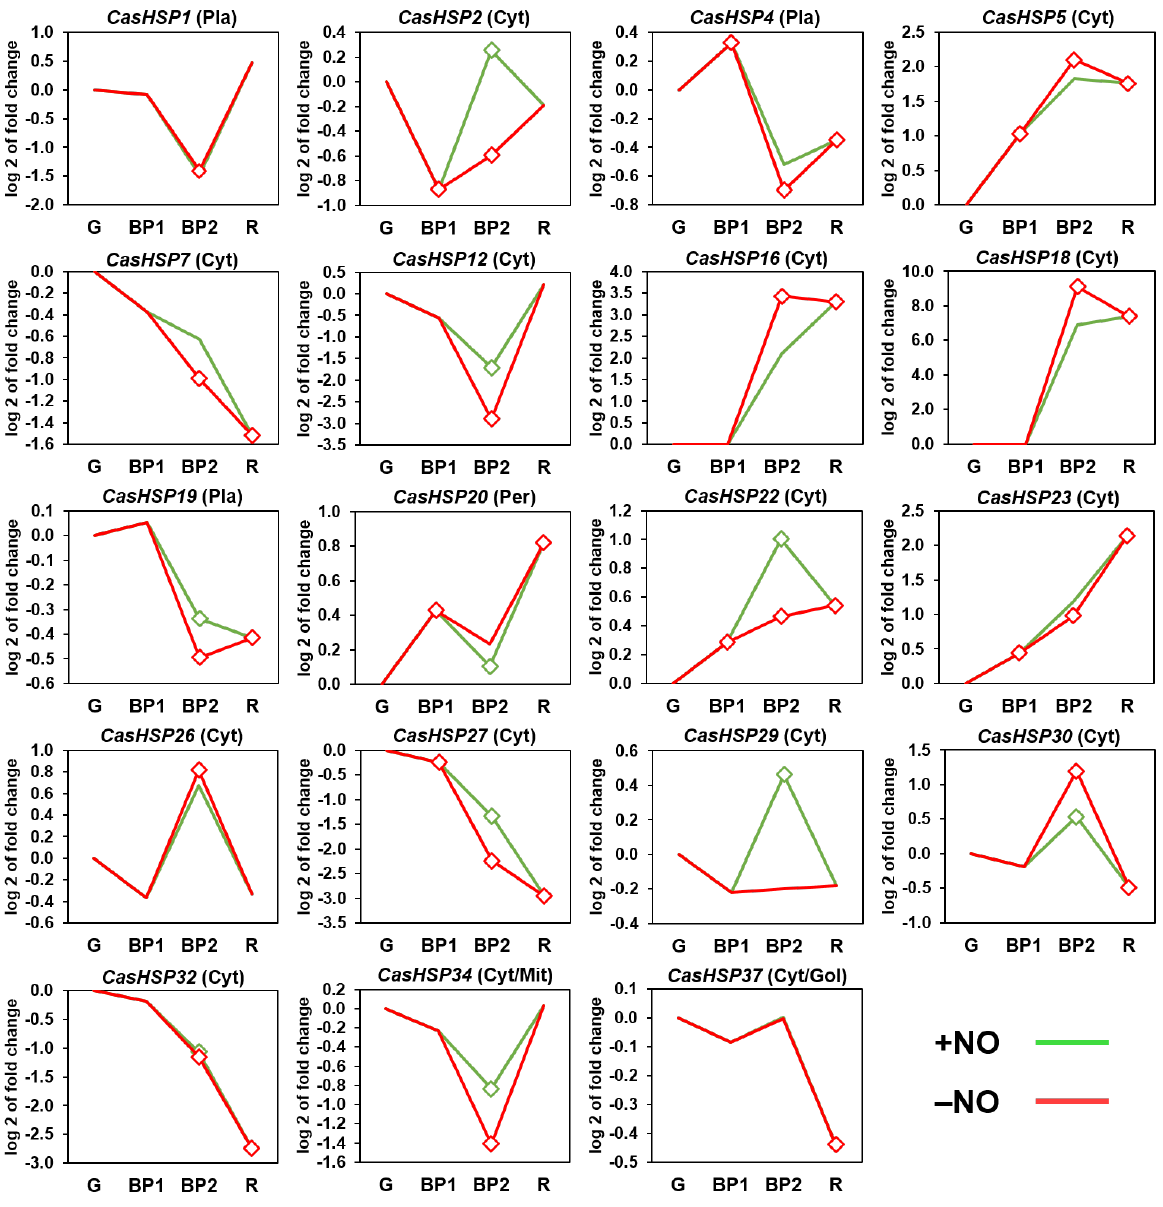
Figure 4. Time-course expression analysis of nineteen CasHSP genes (RNA-Seq) under natural ripening conditions and after exogenous NO gas treatment. Samples of sweet pepper fruits at different ripening stages correspond to immature green (G), breaking point 1 (BP1), breaking point 2 with (green line) and without (red line) NO treatment (BP2 + NO and BP2 − NO, respectively) and ripe red (R). Diamonds indicate statistically significant changes in expression levels ( p < 0.05) in comparison to immature green (G). Cyt, cytosol. Mit, mitochondrion. Nuc, nucleus. Pla, plastid. Pex, peroxisome.